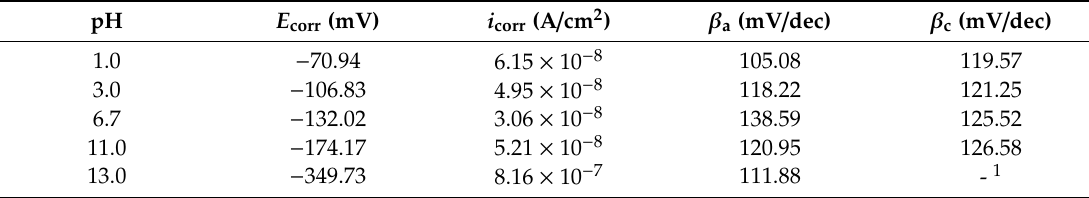
Table 2. The corrosion parameters obtained from the PDP measurements for the galena electrode in NaCl solutions of different pH values.